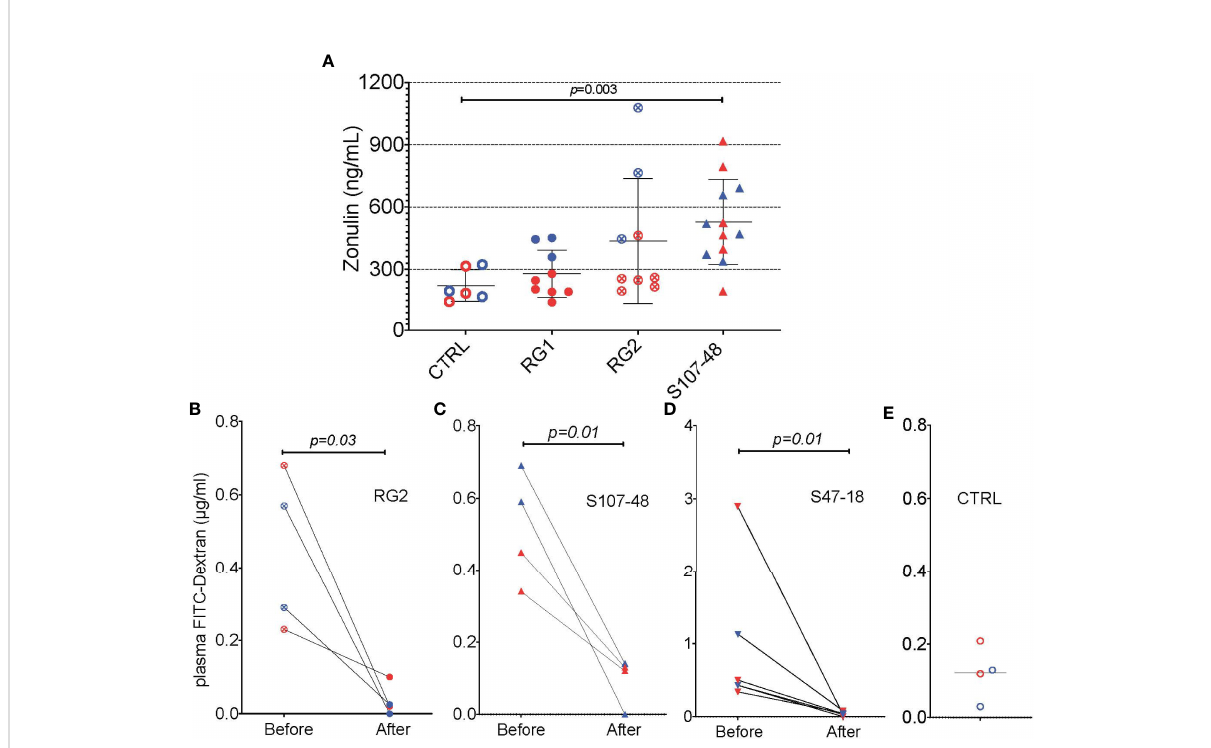
FIGURE 9 Oral larazotide treatment normalizes increased gut permeability induced by RG strain neonatal colonization. (A) Plasma zonulin levels in 14- week-old mice after neonatal colonization, were signi fi cantly elevated in S107-48 RG strain mice compared to non-colonized controls (n = 5 to 12 mice). For each group mean+/-SD. In littermates from RG colonized SPF breeding pairs, individual mice were retested with results shown (before), then after a ten-day treatment with larazotide peptide in the water supply and 48 hr rest, gut permeability was then retested (after), with plasma FD4 levels shown for; (B) RG2 strain colonized mice, (C) S107-48 RG Lupus strain colonized mice, (D) S47-18 RG Lupus strain colonized mice, with comparison to (E) levels detected in non-colonized control mice. For the bottom panels, signi fi cance was tested by paired t test. p<0.05 was considered statistically signi fi